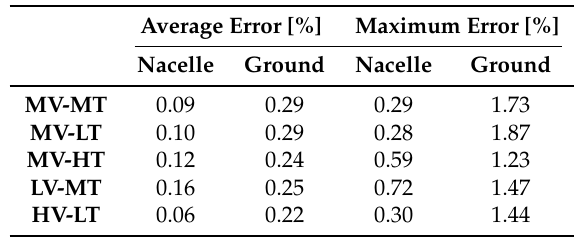
Figure 3. Example of errors in the reconstruction of the longitudinal average velocity component associated only with the assumption of unidimensional flow. The errors correspond to the MV-MT inflow case and for the lidar installed on the nacelle ( a ) and at the base of the tower ( b ). The volume of interest is delimited by the white dashed line. The figures show the error as a percentage of the undisturbed wind speed at hub height (see Section 2.1.3). Table 3. Errors in the reconstruction of the average longitudinal velocity component associated only with the assumption of unidimensional flow. The errors are presented for the different inflow cases studied in terms of average and maximum values found within the volume of interest (see Section 2.3 and white dashed lines in Figure 3) for both nacelle-mounted and ground-based lidars. Percentages are based on the undisturbed wind speed at hub height (see Section